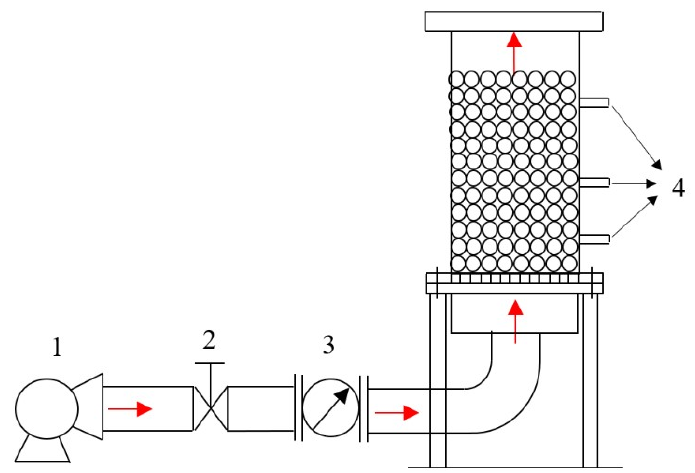
Figure 1. Schematic diagram of air flow experimental device: 1. Air blower, 2. Throttle valve, 3. Orifice plate flowmeter, 4. Pressure measuring holes. Orifice plate flowmeter, 4. Pressure measuring holes.